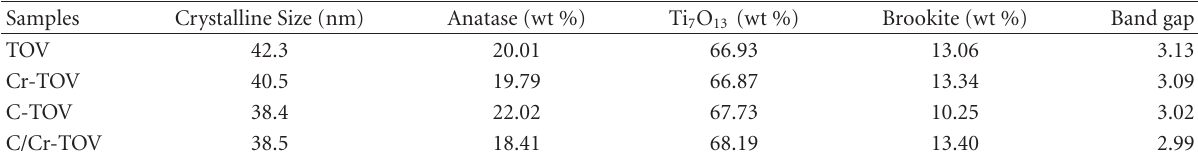
Figure 1: XRD patterns of samples with di ff erent oxygen defects: (a) undoped TiO X , (b) C-doped TiO X , (c) Cr-doped TiO X , and (d) C/Cr- doped TiO X . (e)–(h) are magnified XRD spectra of (a)–(d), respectively. Table 1: Physicochemical properties of the TiO X samples.